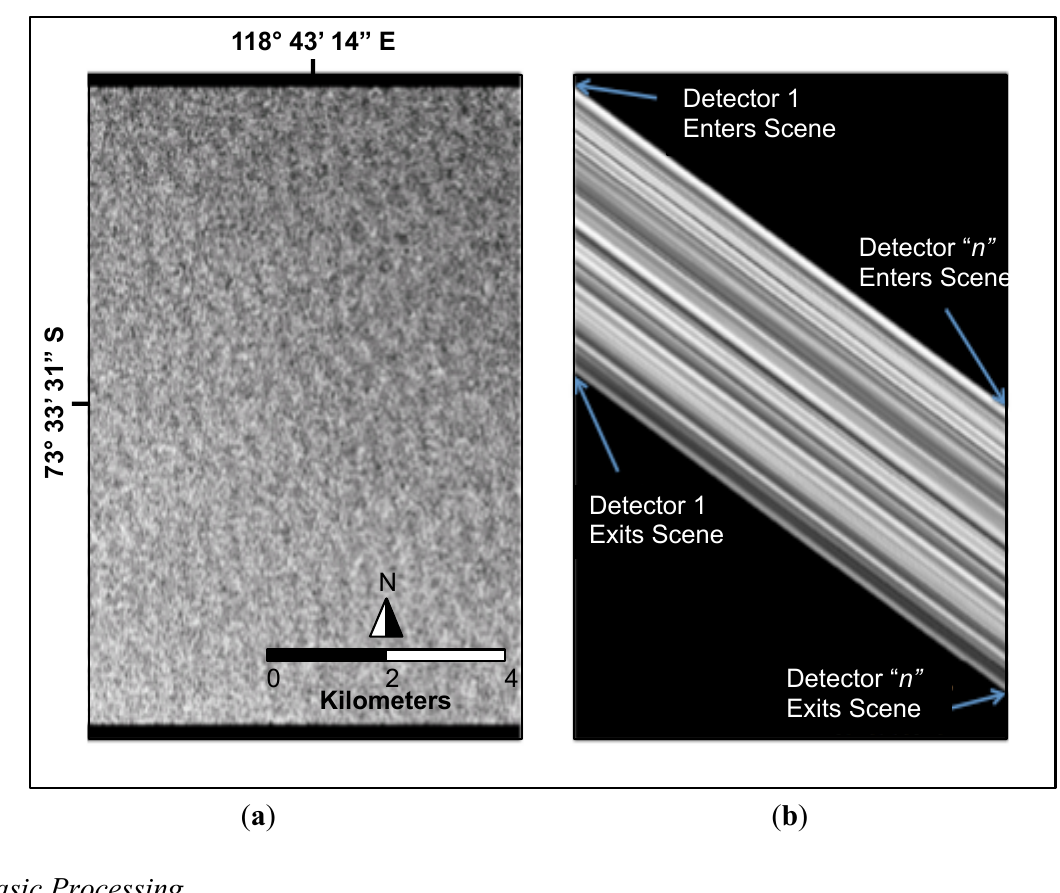
Figure 3. DIRSIG simulated grayscale images collected over Dome Concordia, Antarctica in both (a ) normal mode and ( b ) side slither